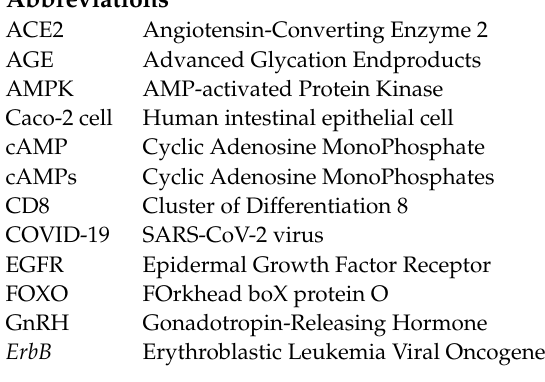
107 compounds. Table S2: The overlapping genes of SEA and STP: 399 Genes. Table S3: COVID 19-related genes: 356 genes. Table S4: Final 27 overlapping genes related to COVID-19. Figure S1: (A) Interactions between two bioactive compounds and RELA (PDB ID: 1NFI). (B)